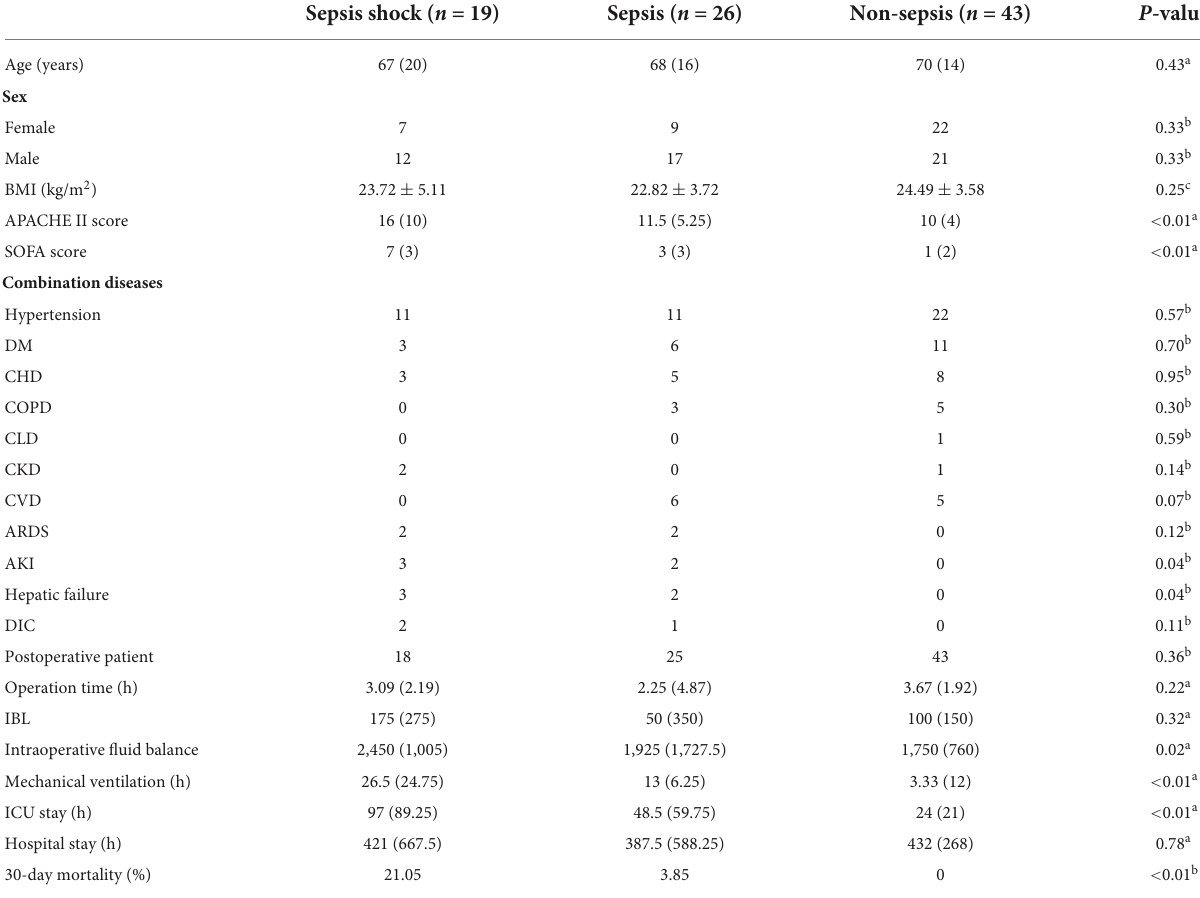
TABLE 1 Demographics and baseline